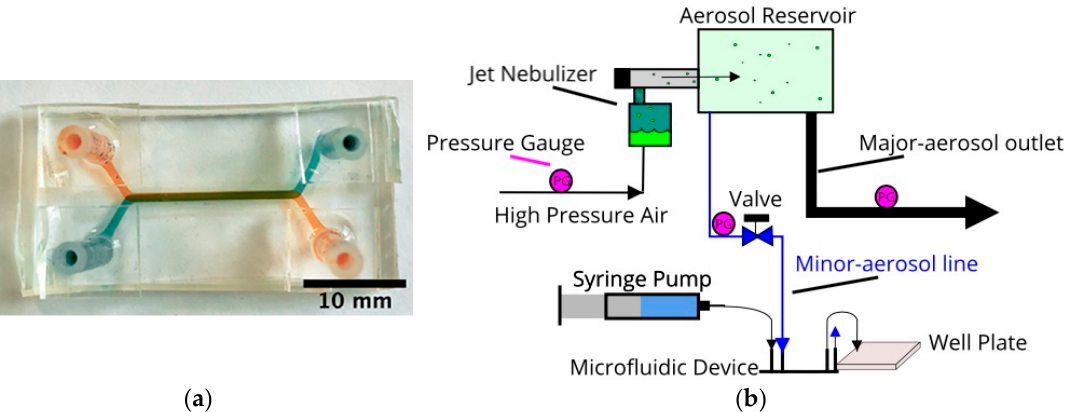
Figure 1. ( a ) A photograph of a fabricated and packaged microfluidic bilayer device with green dye in the top and orange dye in the bottom microchannel. ( b ) A schematic representation of the jet nebulizer setup; the aerosol system is connected to a microdevice’s top channel while the bottom channel is connected to a syringe pump to drive media across the device.